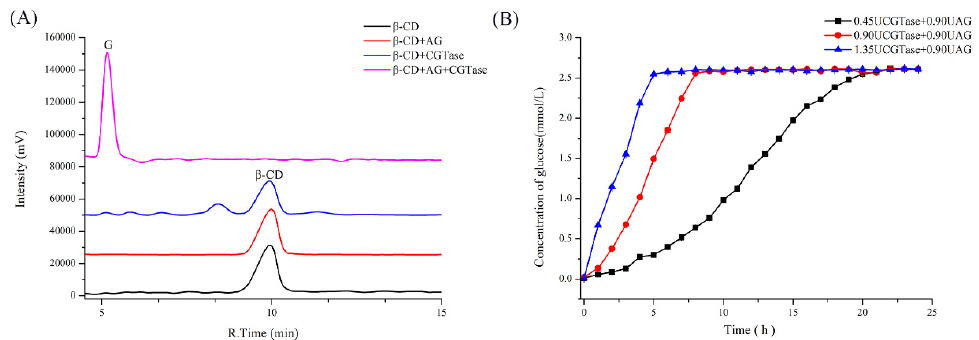
Figure 1. ( A ) The HPLC profile of the products obtained from β -CD by action of β -CGTase, AG, and dual enzymes and ( B ) the formation of glucose from β -CD by the action of various combinations of β -CGTase and AG.